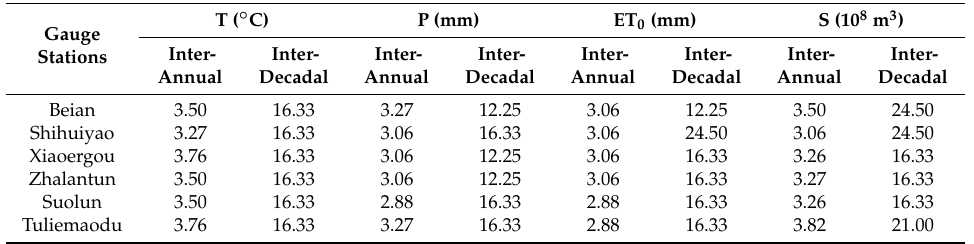
Table 3. Trends (Tre) and transition years (TraY) for temperature (T), precipitation (P), evapotranspiration (ET 0 ), and streamflow (S) variations during 1961–2010 for six gauge stations in the headwater region of the Nenjiang River Basin, Northeast China.